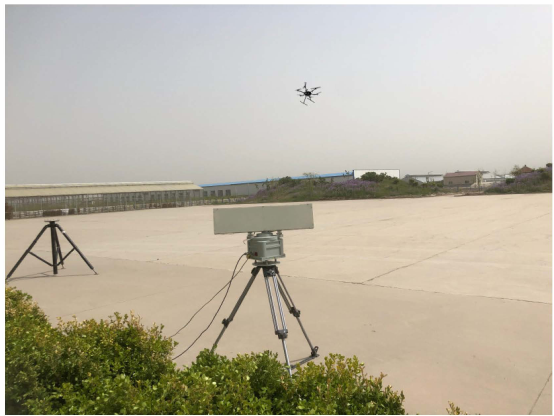
Figure 13. Experimental scenario.